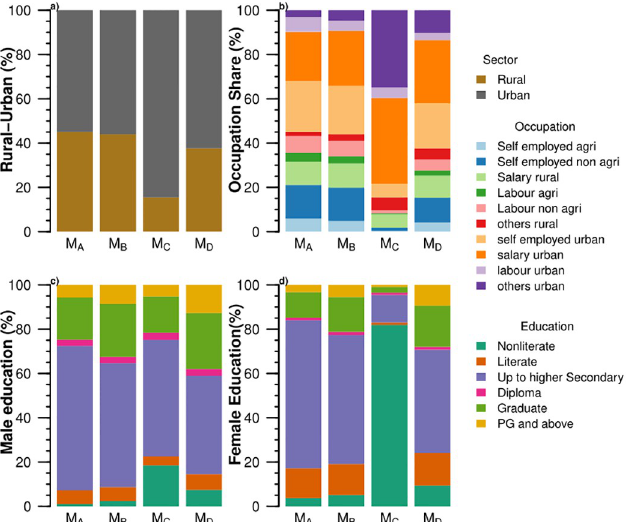
Fig 7. Socioeconomic features of Market-based food systems (M urban households, (b) the share of occupation classes, (c) the share of the highest education among male members, and (d) the share of the highest education among female